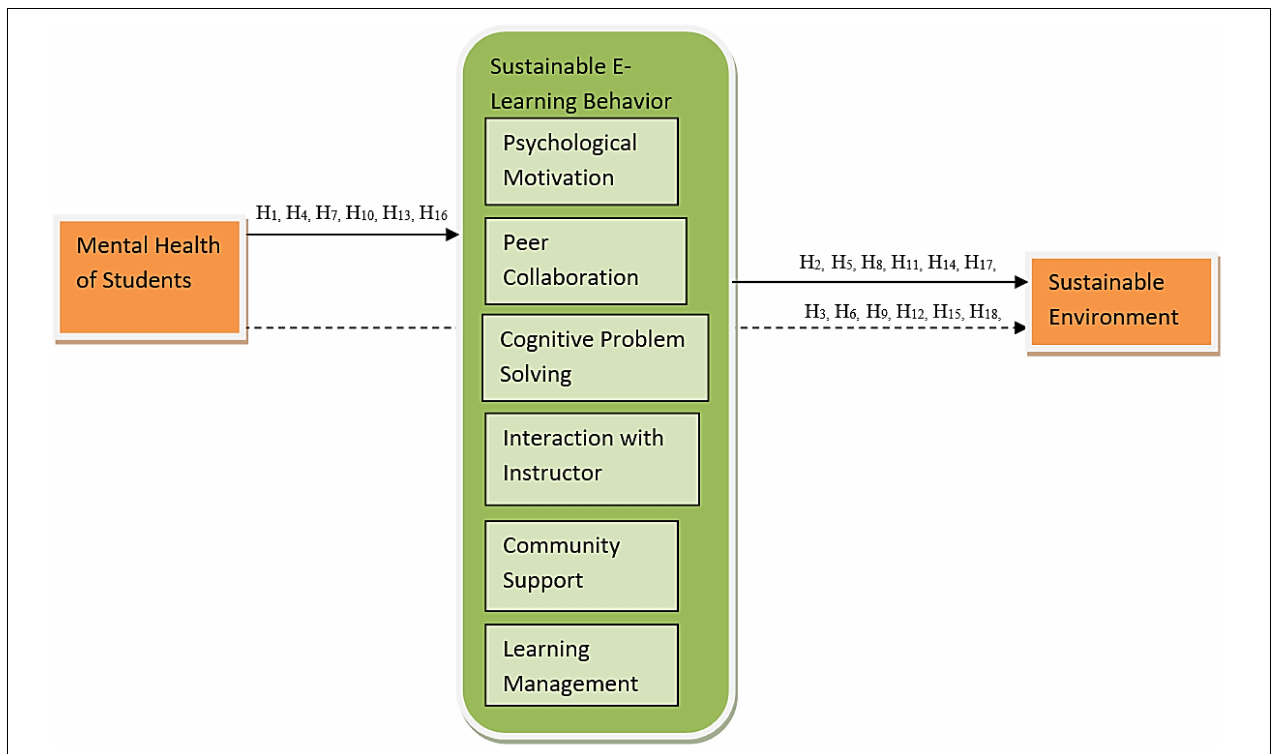
FIGURE 1 | Theoretical framework. N = 340, CPS, cognitive problem-solving; CS, community support; IWI, interaction with instructor; LM, learning management; MH, mental health; PM, psychological motivation; PS, peer collaboration; SE, sustainable environment.